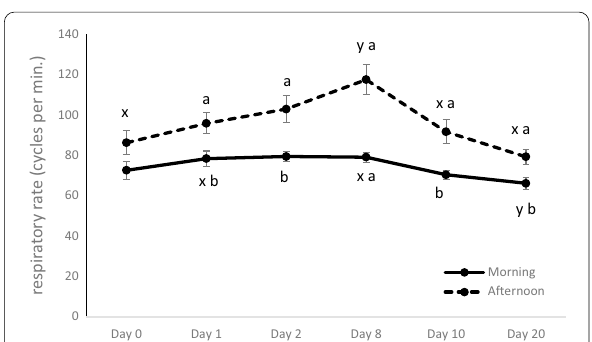
Fig. 3 Diurnal changes in respiratory rate of neonatal Nigerian goats from birth to Day 20. Values with a , b and x , y indicate significant different ( P < 0.05) between different hours of the day and ages,